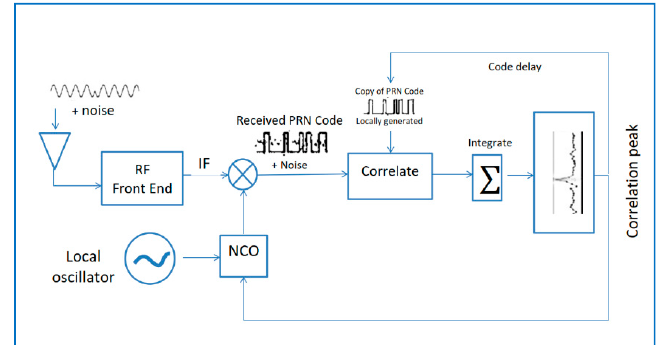
Figure 3. Basic GPS receiver architecture.